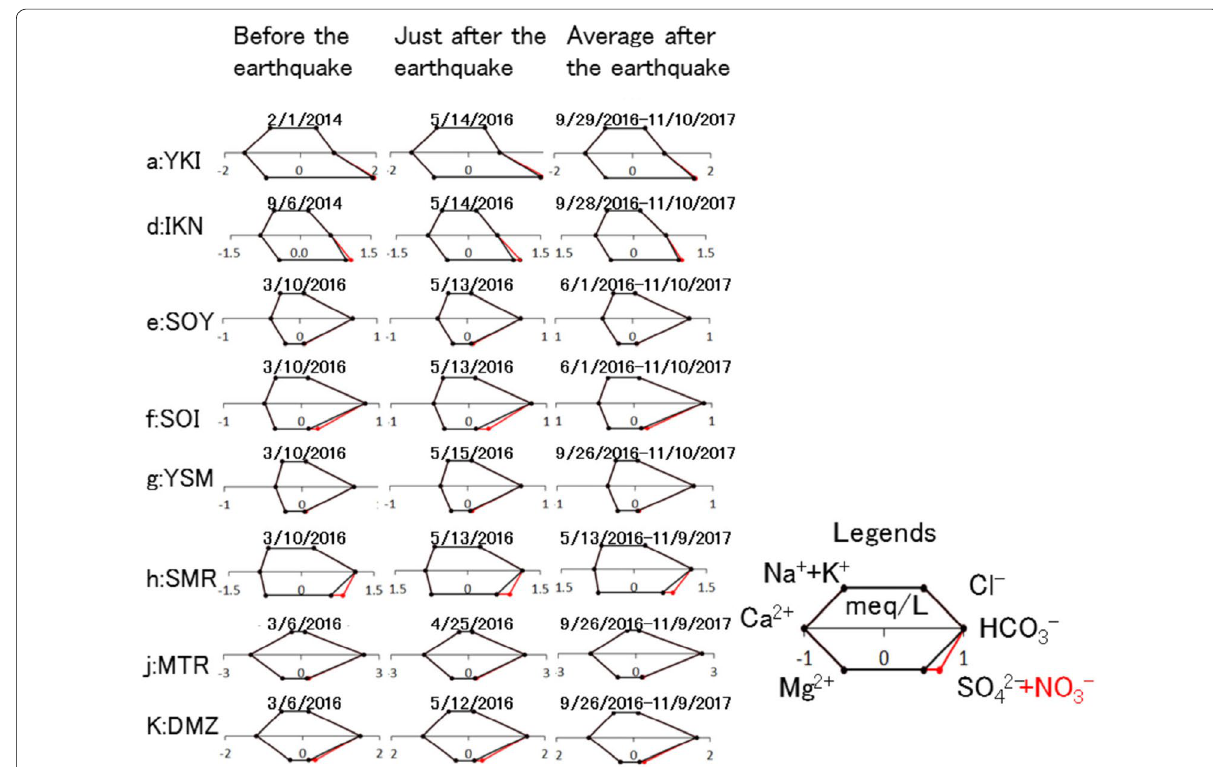
Fig. 9 Chemical composition at eight springs before and after the 2016 Kumamoto earthquake. The sampling date is shown above each hexa diagram. The precision is about a few to